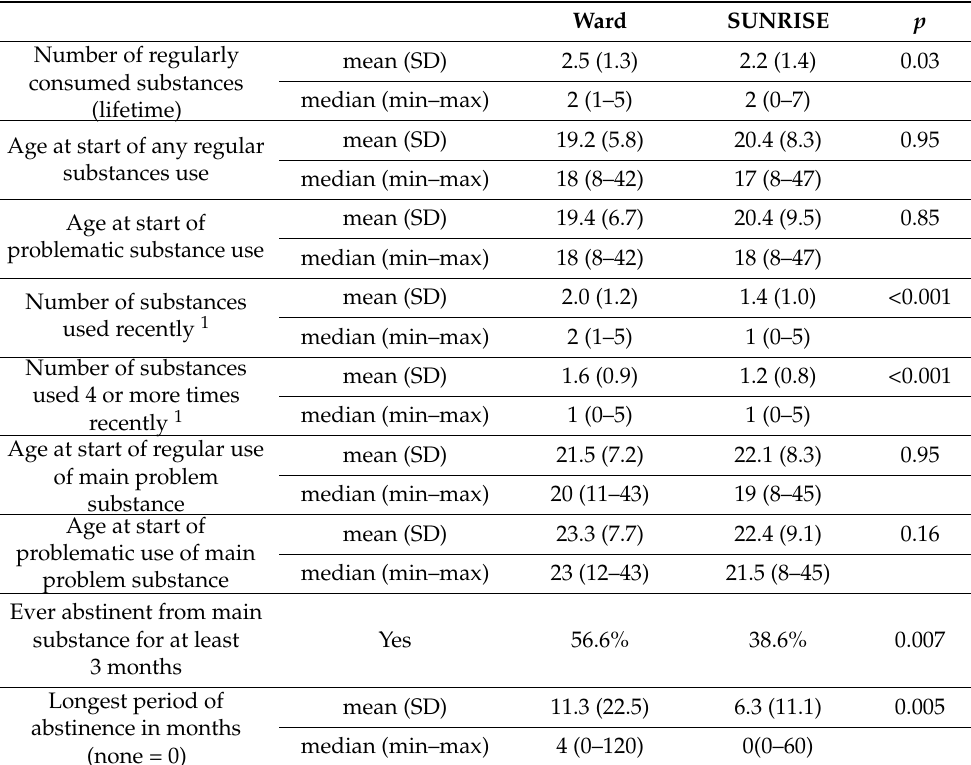
Table 2. Prevalence of substance use, excluding nicotine; comparison between clinical sample (inpatient ward) and unemployment office sample